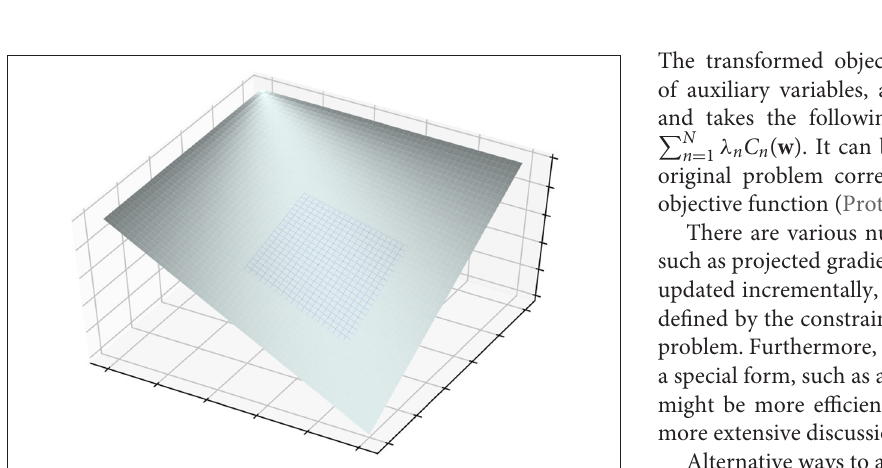
FIGURE 2 | An example of optimizing a function, while constraining the solution to lie on the shaded